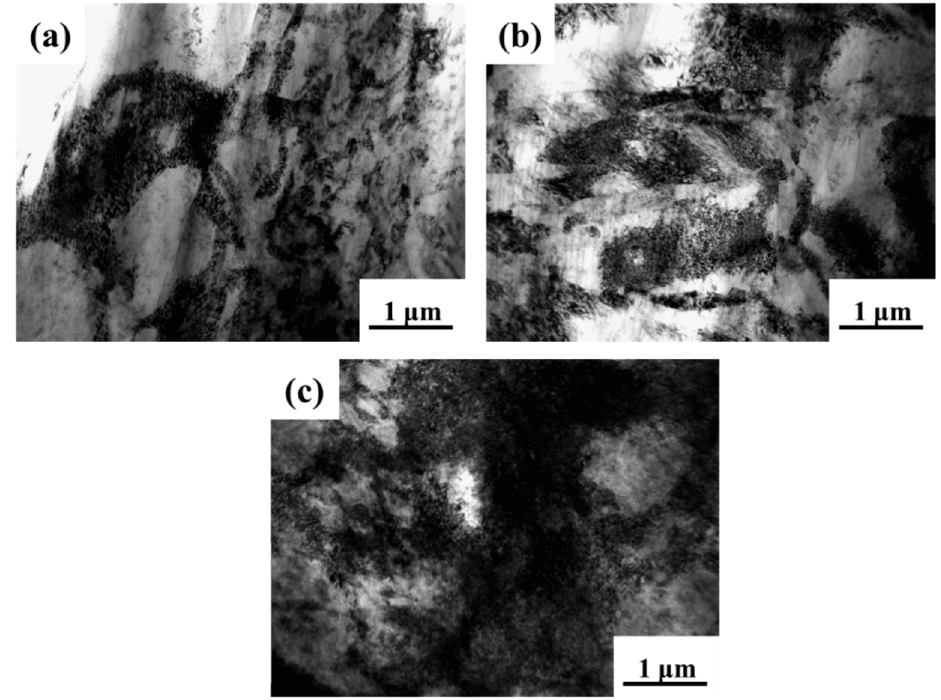
Figure 7. The dislocation density of AZ31–V P powders with different V P contents after milling for 90 h: ( a ) 5 wt %, ( b )7.5 wt %, ( c )10 wt %.